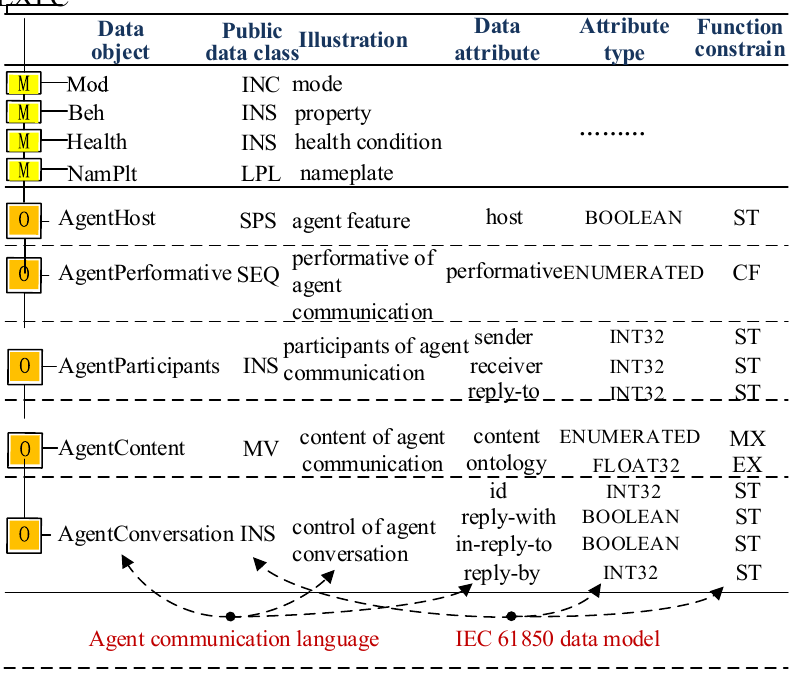
Figure 3. Data model of